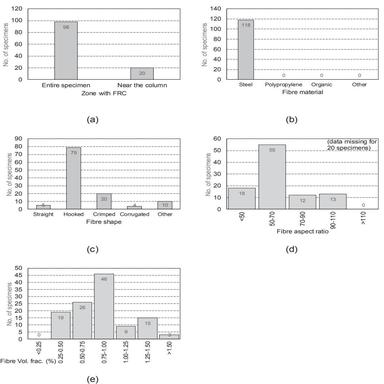
Histograms of tested FRC properties in monotonic punching tests of flat slab specimens with normal-weight FRC with conventional aggregates, excluding small scale specimens: a) zone with FRC; b) fibre material; c) fibre shape; d) fibre aspect ratio; e) fibre volume fraction.